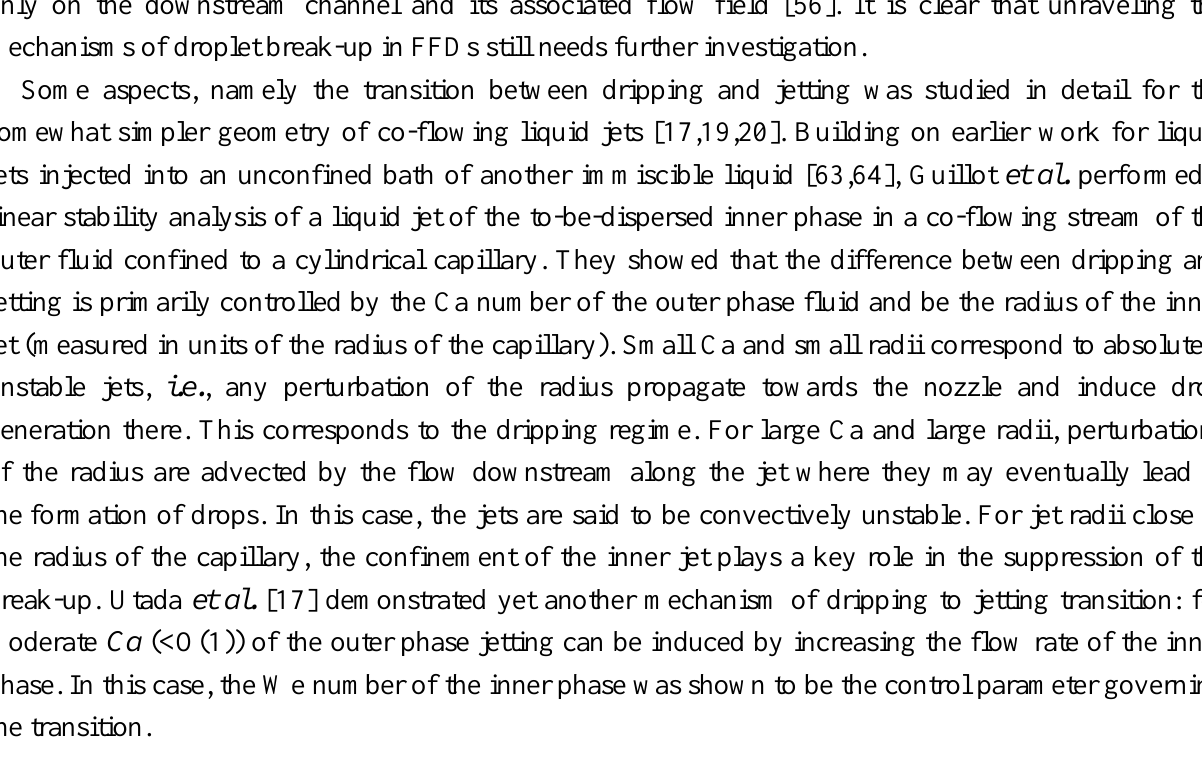
Figure 6. Different droplet breakup processes: ( a ) squeezing; ( b ) tip-streaming; ( c ) dripping, and ( d ) jetting. Reprinted from [56] with permission from the American Institute of Physics